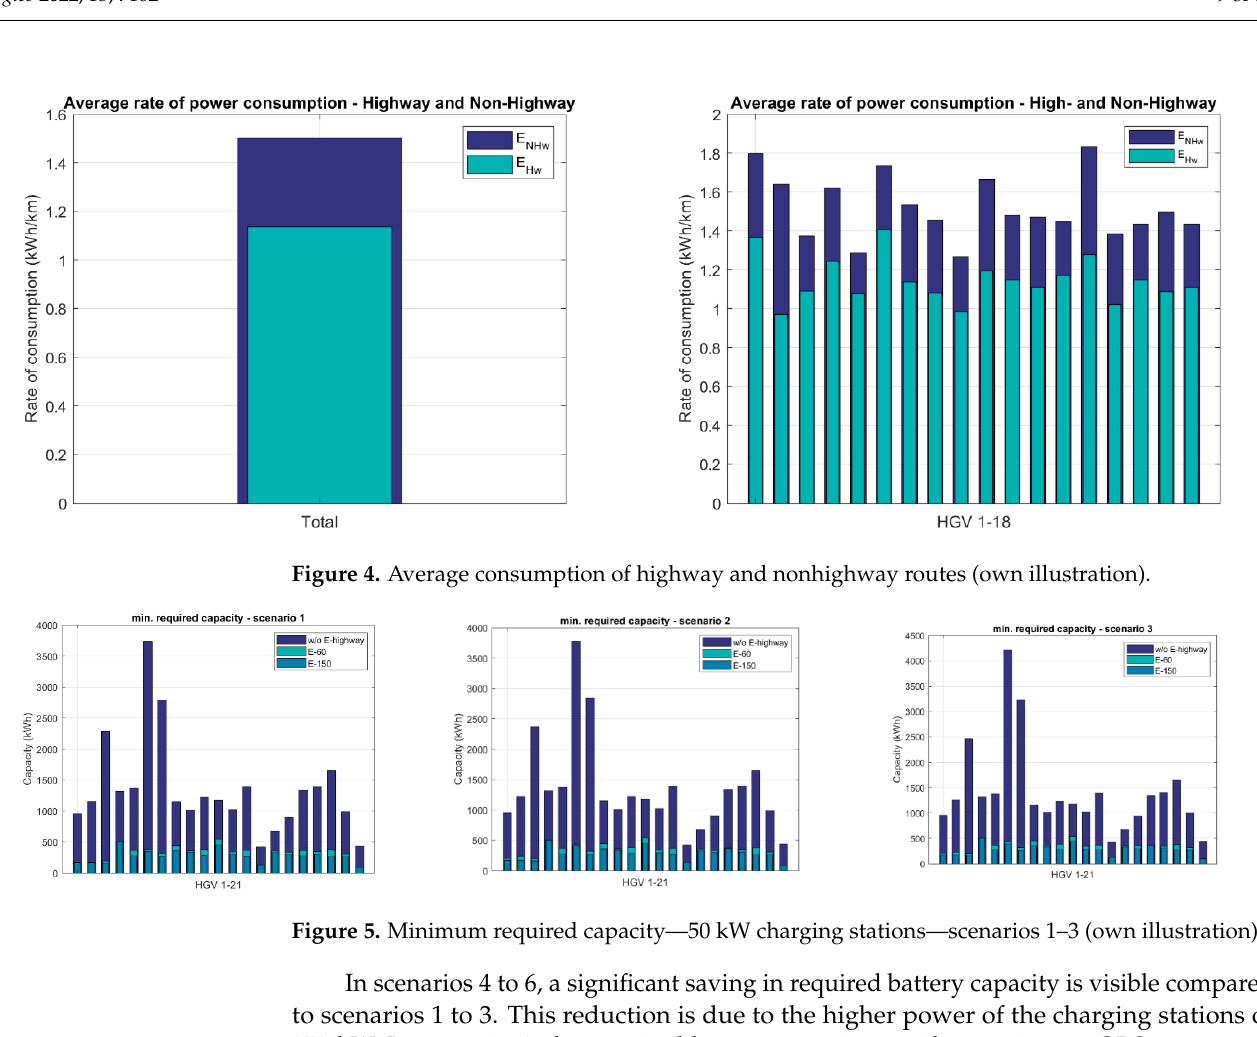
Figure 5. Minimum required capacity — 50 kW charging stations — scenarios 1 – 3 (own illustration).